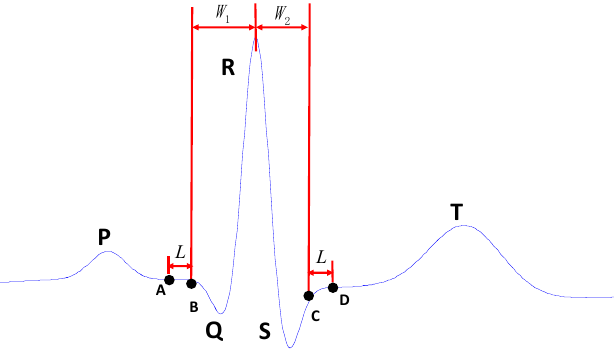
Figure 3. A representation of One AECG cycle.